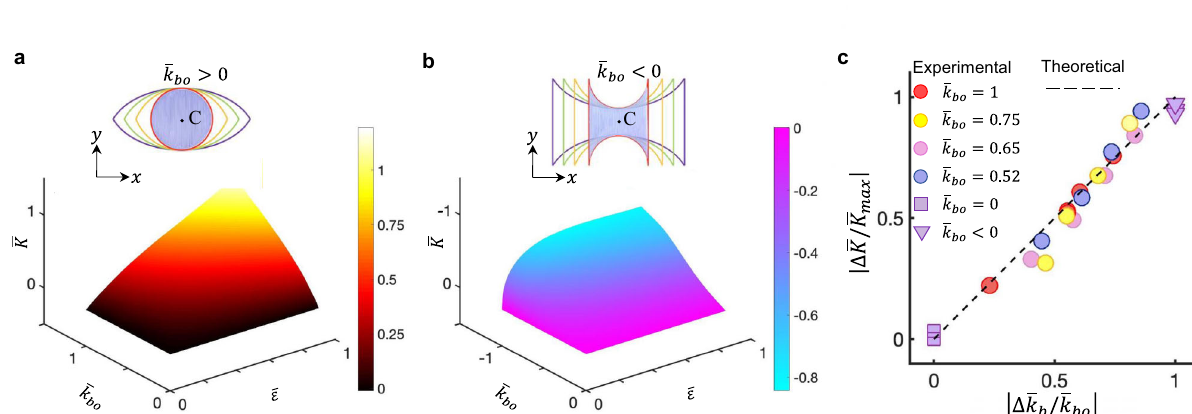
Fig. 3 Quantifying the correlation between the boundary curvature and the Gaussian curvature. a , b Theoretically predicted 3D maps of the normalized Gaussian curvature (cid:1) K at the center point C as a function of the normalized boundary curvature (cid:1) k bo in 2D kirigami precursors (insets) and the applied strain ε for the cases of spherical ( a ) and saddle ( b ) shapes. The color bars represent the normalized Gaussian curvature. c Theoretical and experimental results of the approximately linear relationship between the normalized variation of the Gaussian curvature j Δ (cid:1) K = (cid:1) K max j and the normalized variation of the boundary curvature j Δ (cid:1) k b = (cid:1) k bo j